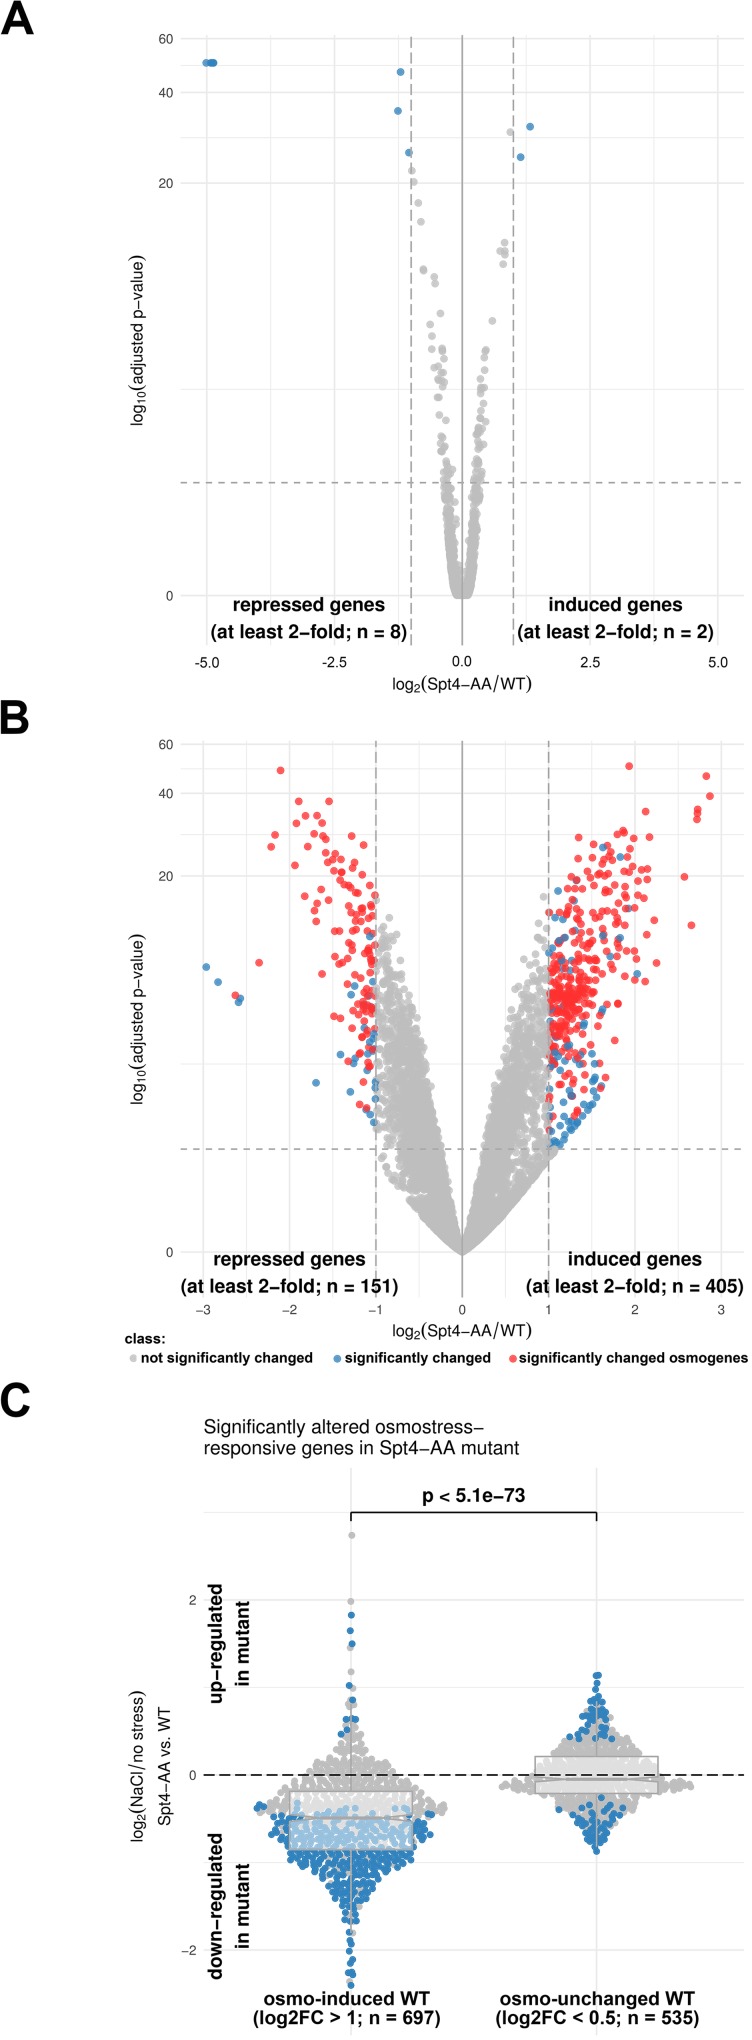
The Spt4T42AS43A mutant is deficient in the induction of stress-responsive genes.(A) Volcano plot showing significantly altered gene expression of Spt4T42AS43A (Spt4-AA) mutant versus wild type (WT) strains in non-stressed conditions. n indicated the number of genes significantly altered in the Spt4T42AS43A mutant compared to wild type. (B) Volcano plot showing significantly altered gene expression of Spt4T42AS43A (Spt4-AA) mutant versus wild type (WT) strains upon stress (0.4 M NaCl, 15 min). n indicated the number of genes significantly altered in the Spt4T42AS43A mutant compared to wild type. Known osmo-responsive genes are shown in red dots. (C) Differences in the transcriptional stress-activated and stress-unchanged response of wt and Spt4T42AS43A mutant cells. Horizontal lines in the boxplots indicate the median, dashed grey lines indicate a relative absolute fold change of 1. The indicated p-value is based on a Wilcoxon-test. Blue dots mark genes with significantly altered expression (A and B: |log2FC| > 2, FDR < 0.05, C: FDR < 0.05).